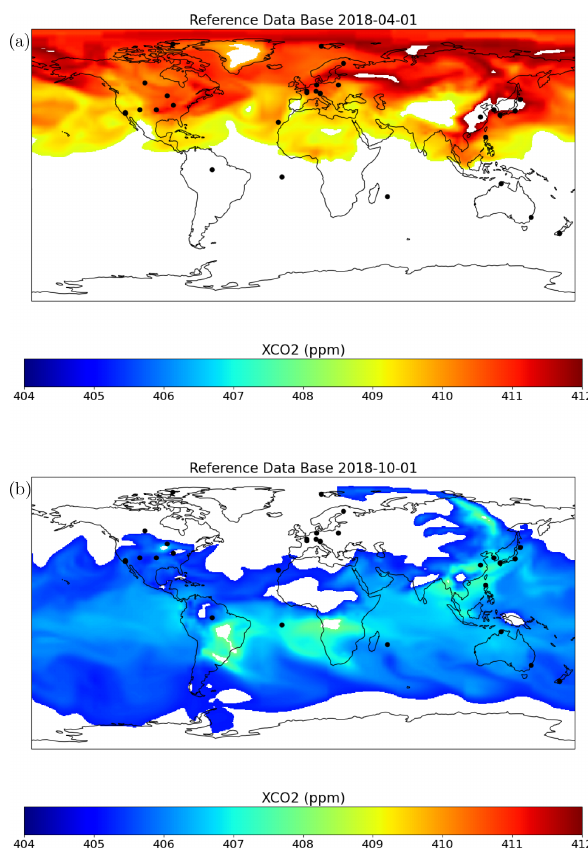
Figure 1. XCO 2 from the GOSAT-FOCAL reference database. The black markers show the locations of TCCON stations. (a) 1 April 2018. (b) 1 October